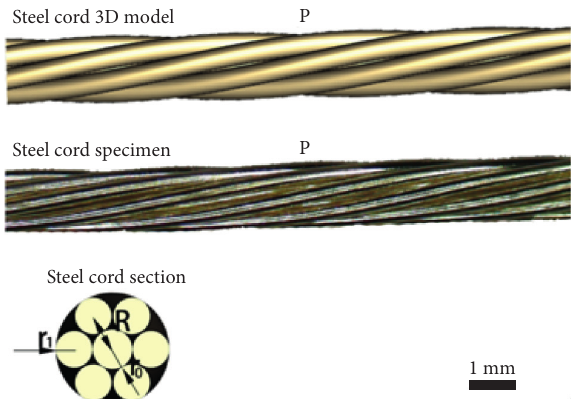
Figure 1: Experimental process.